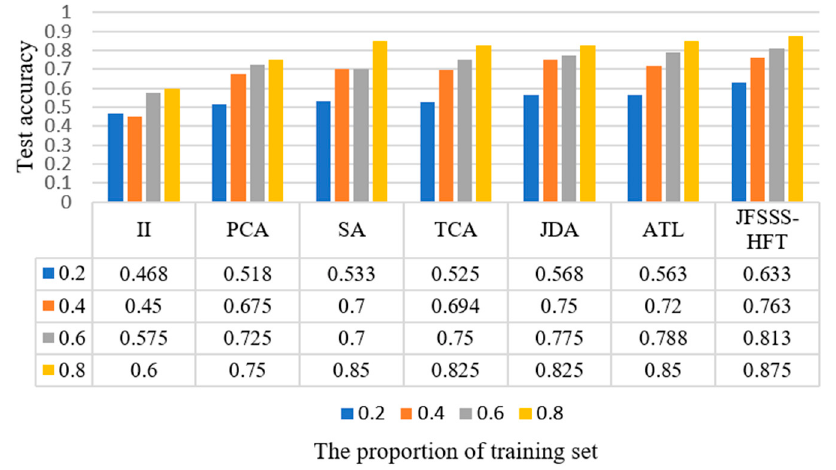
Figure 8. Classification results of different features transfer methods using training set with different sizes of dataset 2.